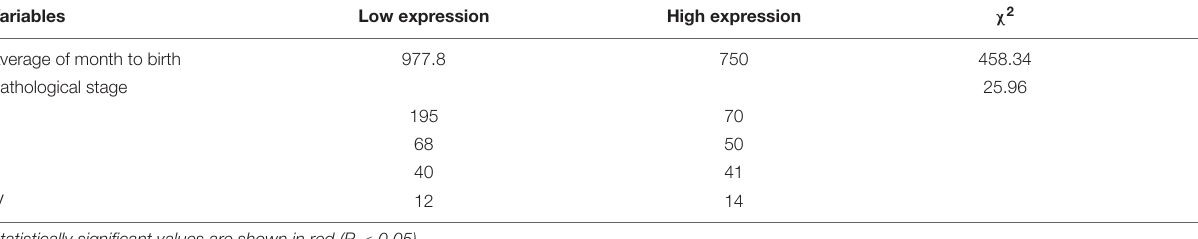
TABLE 2 | Association between KRT6A levels and clinicopathological parameters in NSCLC patients. Variables